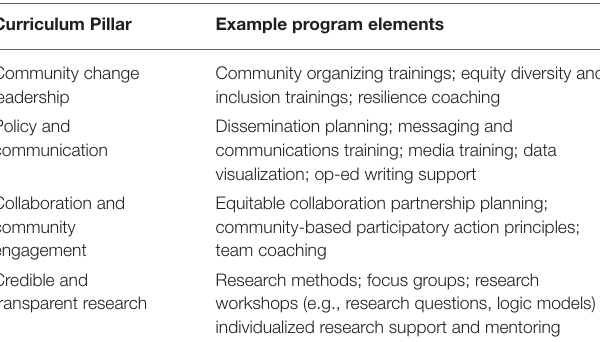
TABLE 1 | Pillars of the IRL curriculum